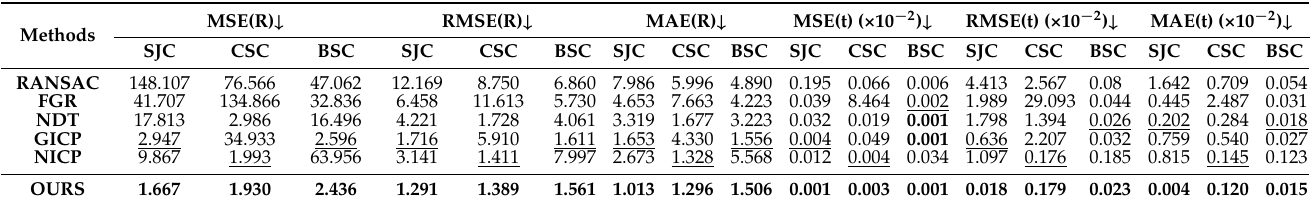
Table 4. Evaluation of the results of the self-built database. On the basis of our self-built test samples, we evaluated the performance of our method and other similar methods. (A smaller value indicates better performance, a bolded value indicates the best performance, and an underlined value indicates the second-best